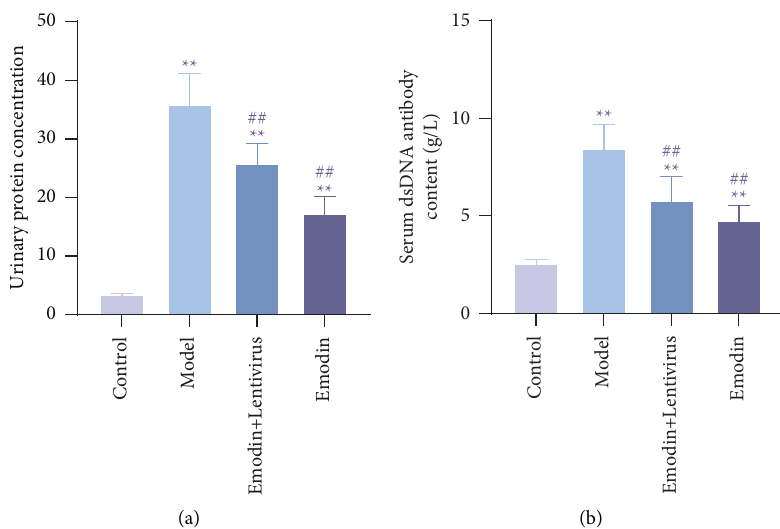
Figure 6: Efect of emodin on urinary proteins and serum dsDNA antibodies in LN rats ( n � 3). (a) Urinary protein levels; (b) dsDNA antibody levels. ∗∗ P < 0 . 01 vs. Control; ## P < 0 . 01 vs.